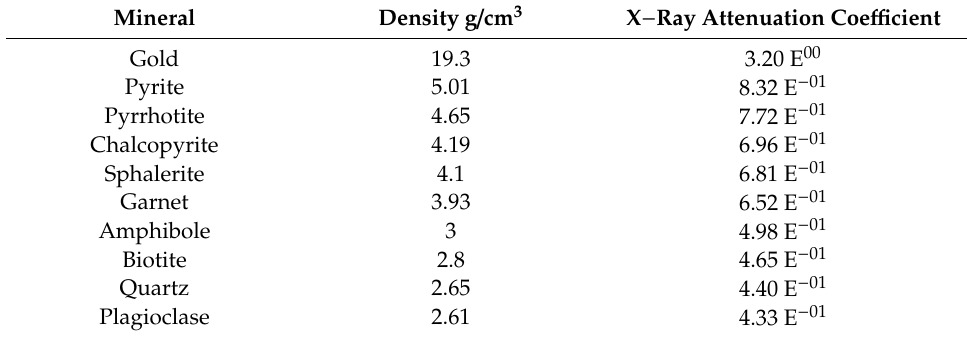
Table 1. Density range and X-ray attenuation coe ffi cients of minerals present in the core samples. Density data are collected from [31] and X-ray attenuation coe ffi cients are calculated using an Excel sheet developed by